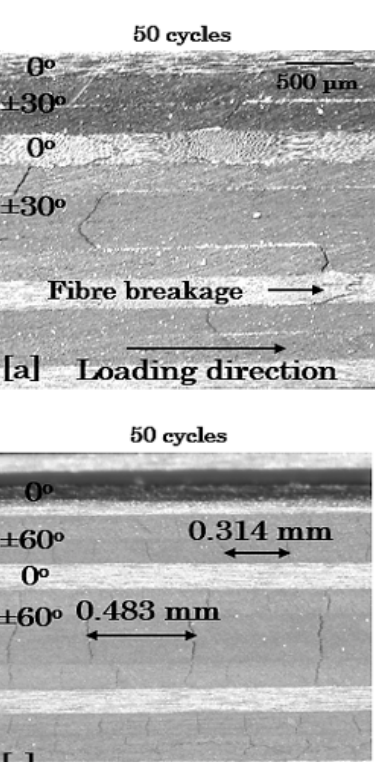
Figure 19. Damage in [0°/30°/0°/ − 30°] s (top) and [0°/60°/0°/ − 60°] s (bottom) laminates after ( a , c ) 50 and ( b , d ) 200 cycles for σ max = 0.8 × σ ult and R = 0.1.